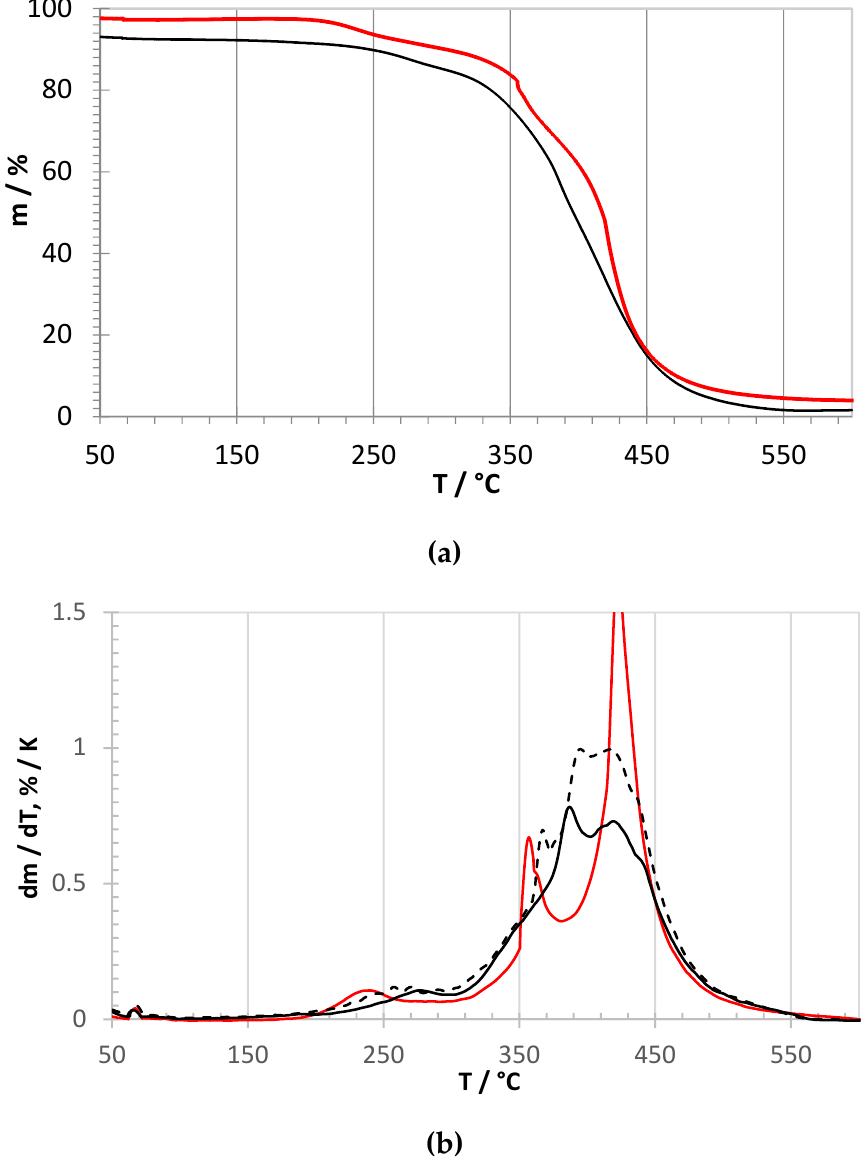
Figure 3. High-resolution thermogravimetric curves under air flow. ( a ) Relative mass loss (black line: PPO-TBD, red line: PPO-TBD-Me). ( b ) Derivative curves. Black lines: PPO-TBD (continuous: pristine, dashed: after 168 h in H 2 O at 60 °C); red line: PPO-TBD-Me).